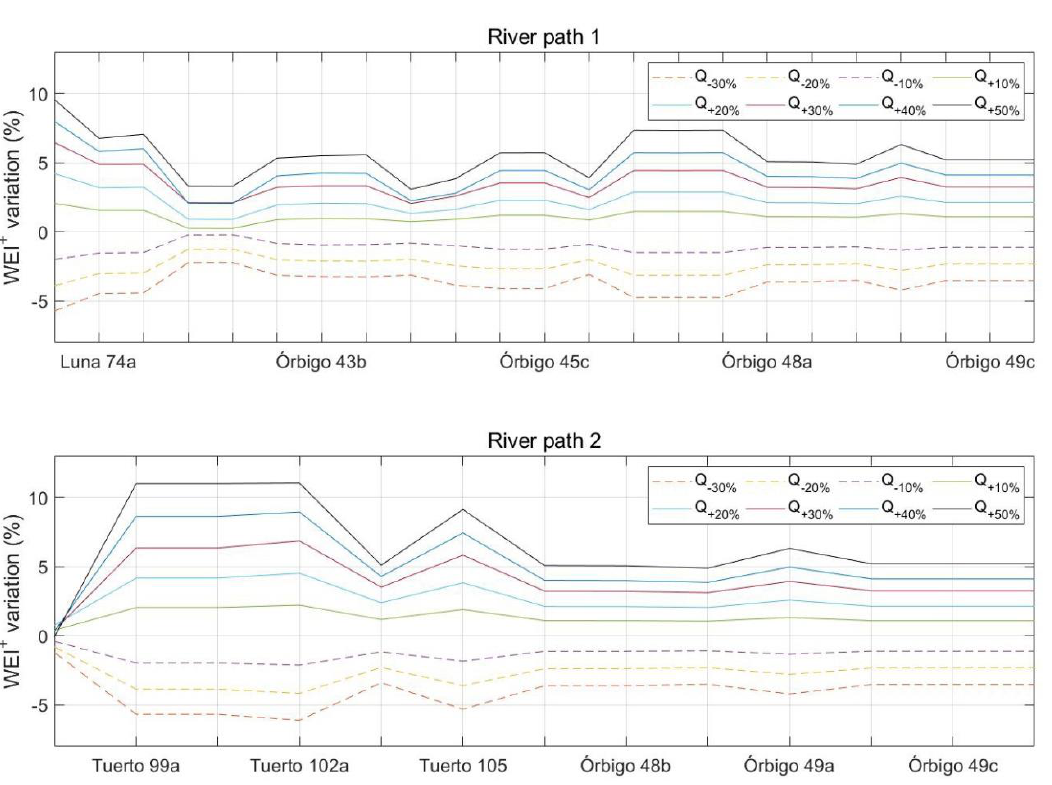
Figure 9. Variation of the WEI + induced by environmental flow scenarios along the two river paths indicated in Figure 1.